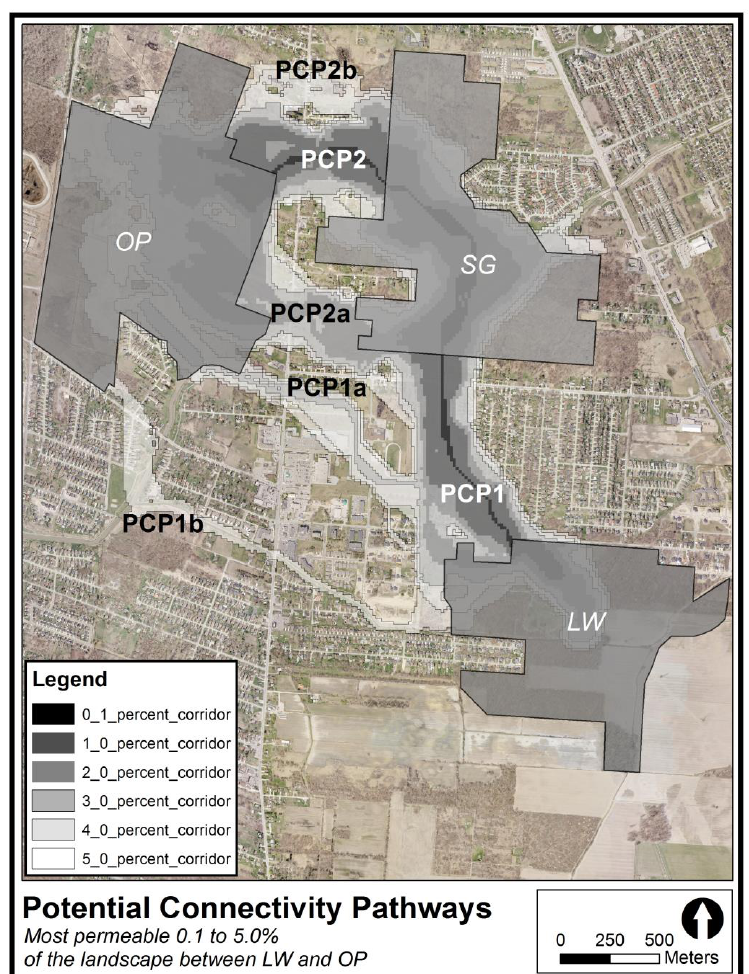
Figure 6. The most permeable 0.1% to 5.0% of the landscape between LaSalle Woodlot (LW) and Ojibway Prairie (OP), for the Massasauga rattlesnake in Windsor / LaSalle, Ontario as indicated by a cost-surface GIS analysis. SG = Spring Garden. Outputs from the LW to SG model (Section 3.1.1) and the SG to OP model (Section 3.1.2) were superficially similar as outputs from the LW to OP model (for PCPs 1, 2, 2a and 2b, with slightly different swath widths and percentages), and are therefore not presented separately.